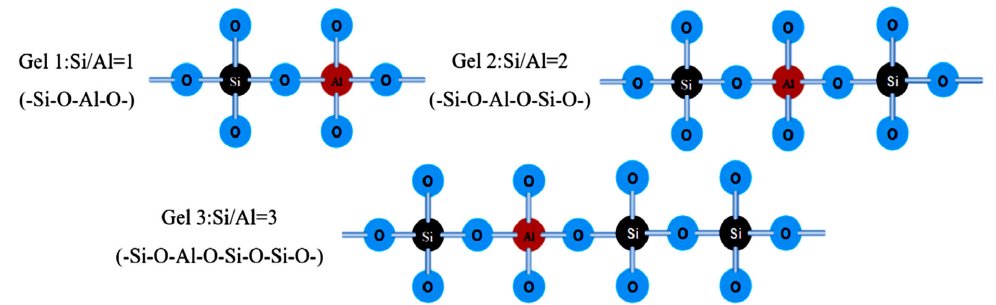
Figure 7. GP structures according to Davidovits [56]. Adapted from [66].